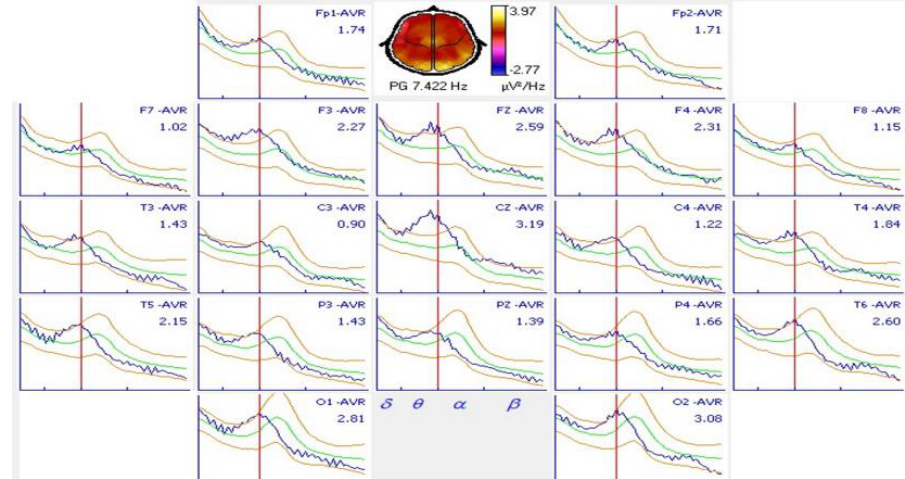
Figure 3. Spectral analysis of an 18-year-old patient with juvenile myoclonic epilepsy and comparison with normal values. A shift in the alpha spectral peak to a 7.422 Hz frequency was observed in all derivations. A normal alpha spectral peak at this age occurs at 10.156 Hz.